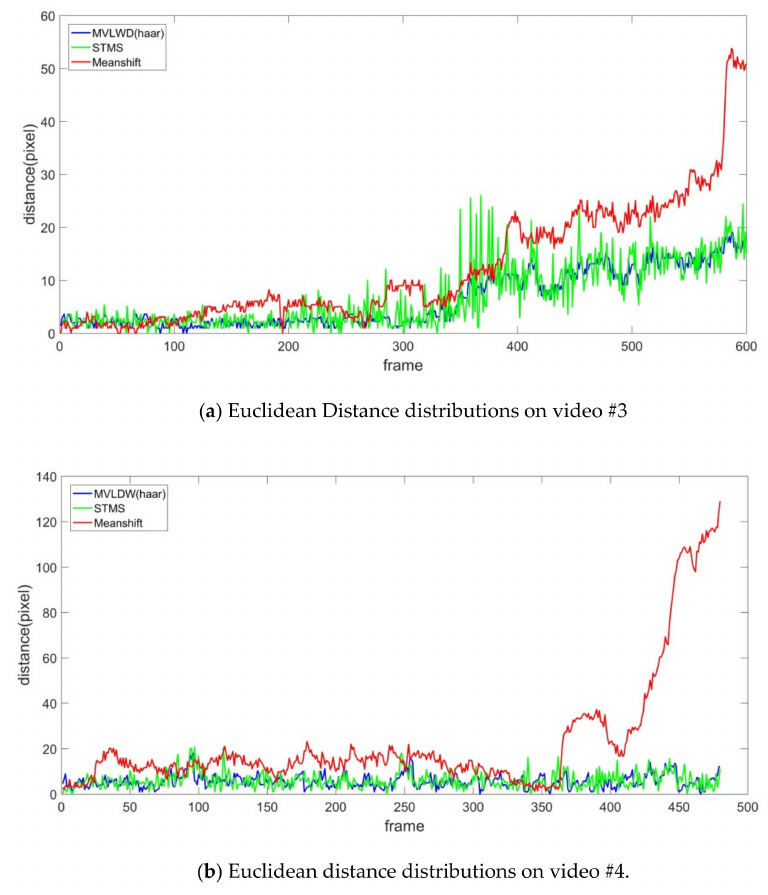
Figure 7. Euclidean distance distribution for the three trackers on video #3 and video #4. Table 3. Statistical performances for the three trackers on video #3.